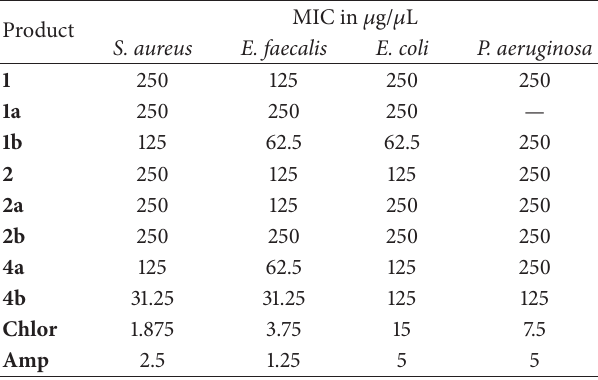
Table 1: Antibacterial activity of the compounds: MIC in 𝜇 g/mL.